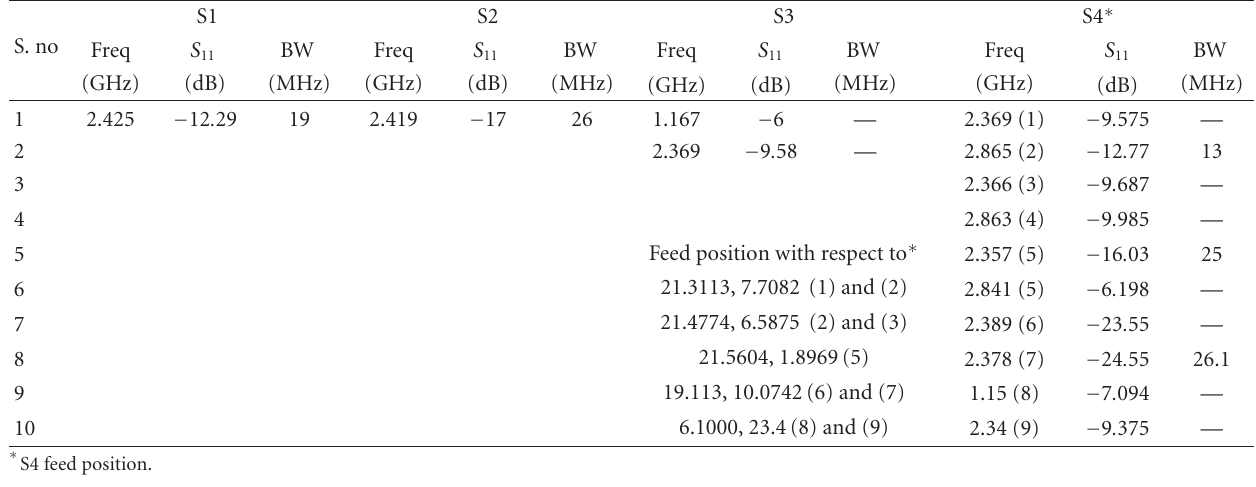
Table 1: Simulated returnloss at various iterations for an self-a ffi ne antenna.